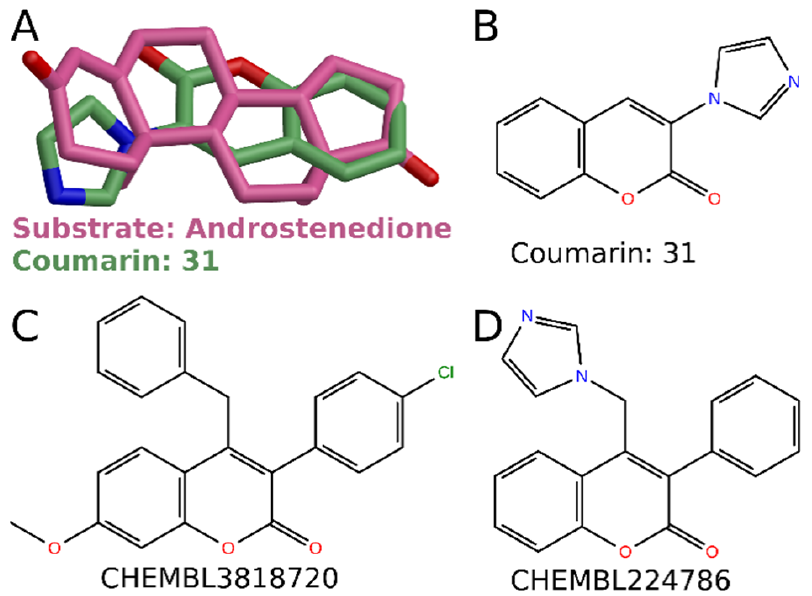
Figure 9. Aromatase inhibitors with a 3-phenylcoumarin core. ( A ) Comparison of possible binding conformations of androstenedione (PDB: 3EQM [22]) and 3-phenylcoumarin 31 at the binding site of aromatase. 2D structures of ( B ) coumarin 31, ( C ) CHEMBL3818720 [20] and ( D ) CHEMBL224786 [21].